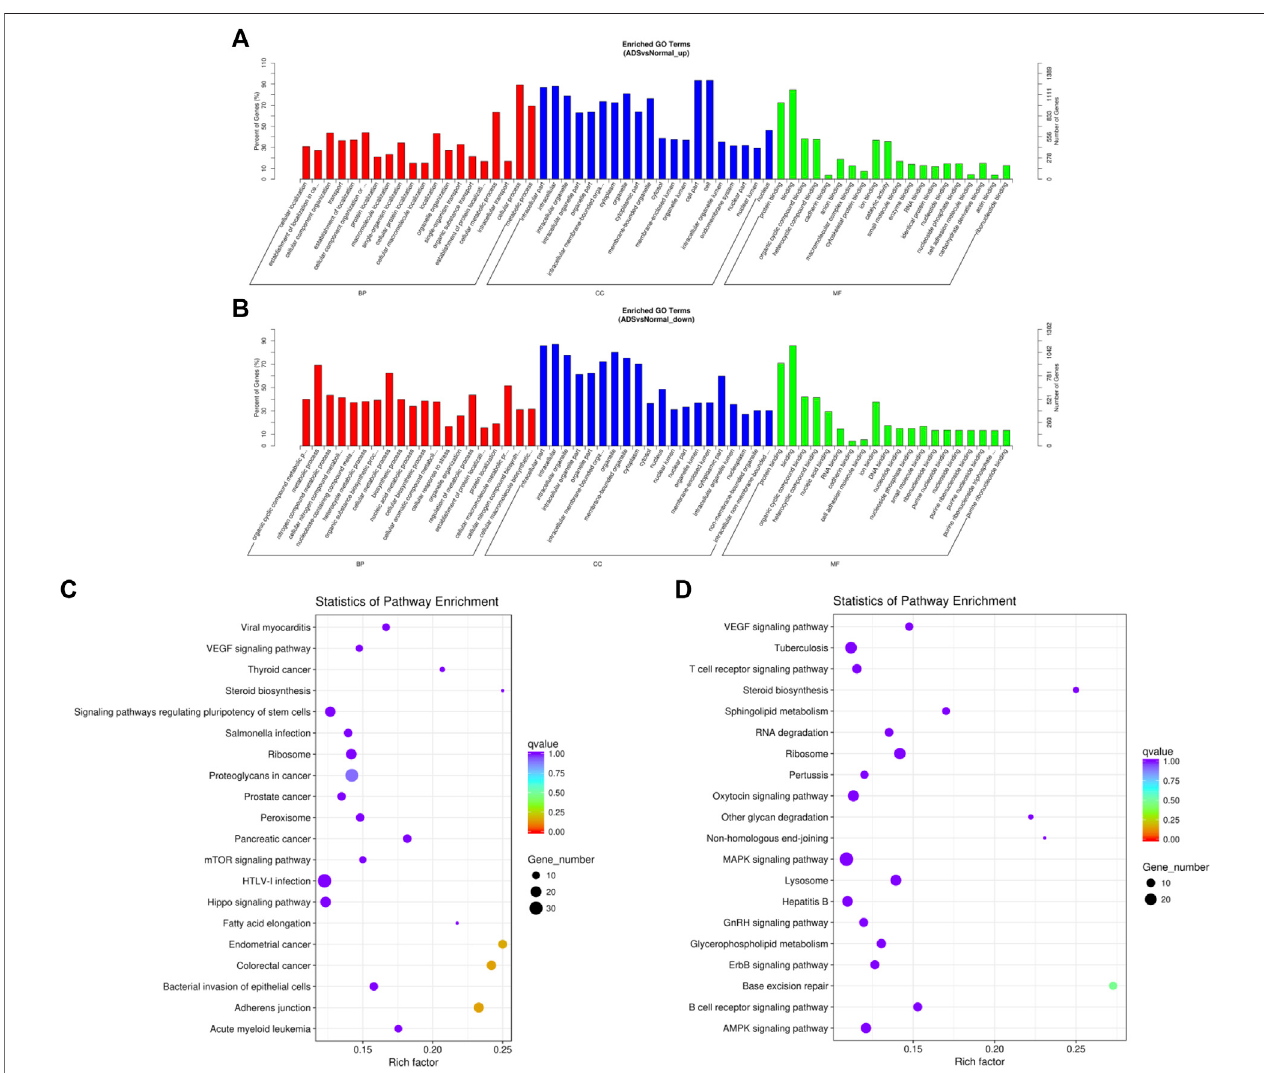
FIGURE 5 | Comparison of functional annotations for differentially expressed mRNAs. The 20 most enriched Gene Ontology (GO) terms for the parental genes of (A) theupregulateddifferentiallyexpressedmRNAand (B) thedownregulateddifferentiallyexpressedmRNA.EnrichedGOtermsareontheverticalaxis,andthenumber of annotated differentially expressed genes associated with each GO term is indicated on the horizontal axis. The 20 most enriched KEGG pathways for (C) the upregulateddifferentiallyexpressed mRNAand (D) thedownregulateddifferentiallyexpressed mRNA.Thesizeofthesymbolrepresentsthenumberofgenes,and the colors represent the p